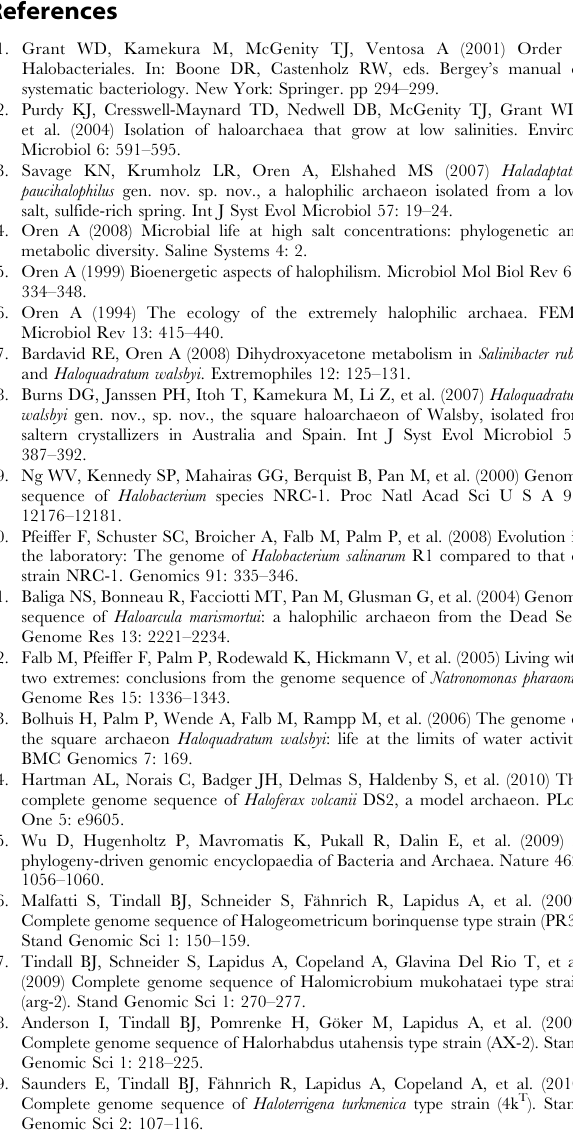
Table S1 Sum of partitioned Bremer support (PBS) values for all OrthoMCL clusters in which at least four ingroup genomes were present, aggregated according to the corresponding COG categories and classes, after correcting for the effect of the number of genomes represented in each cluster and the number of parsi- mony-informative characters. Median support is positive for most categories; the fact that most mean support values are negative is most likely due to the presence of few outliers (see Figure S2). Table S2 Core clusters. Spectral clusters found in all haloarchaeal genomes. For each cluster the predicted function and list of locus tags are listed.